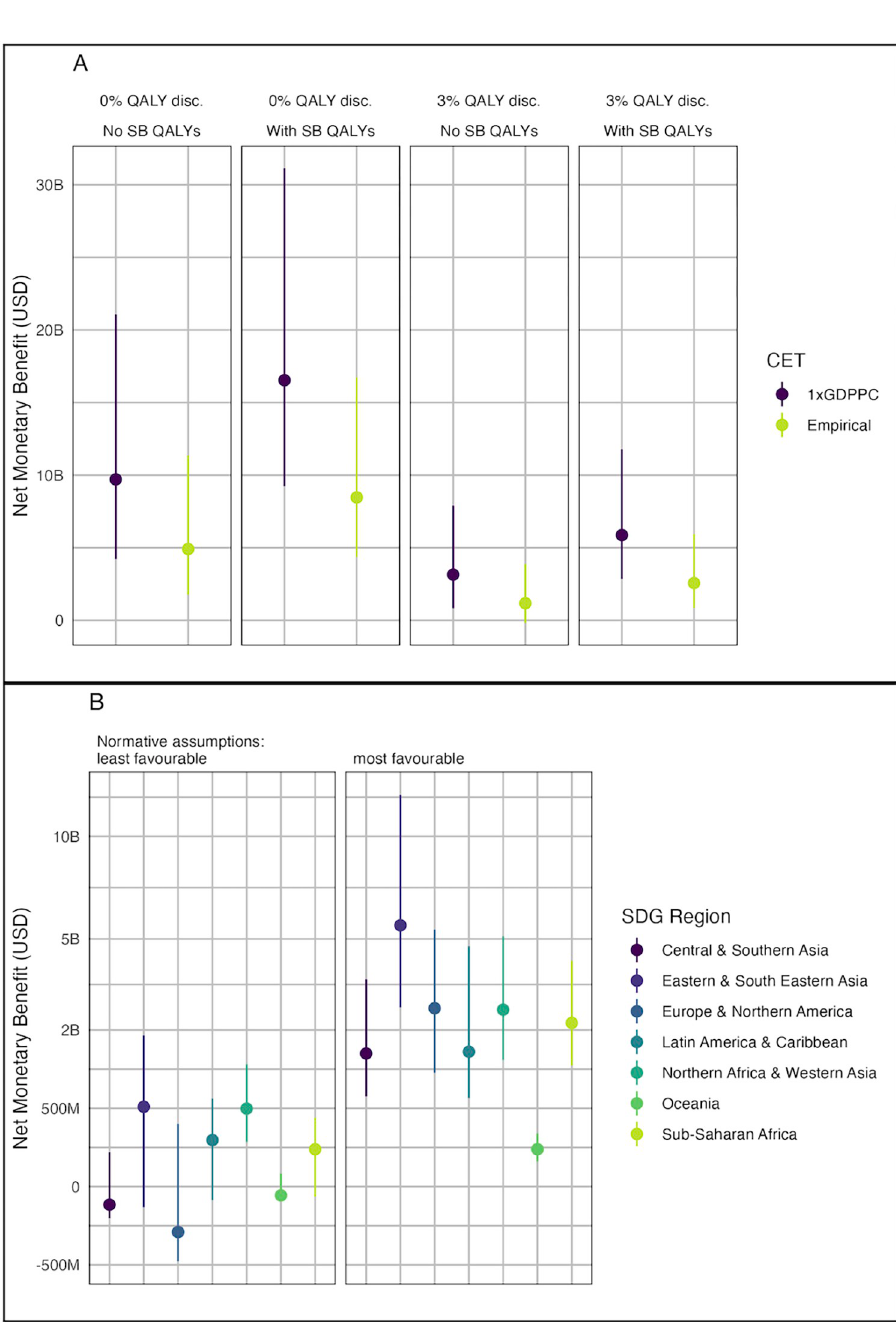
Fig 2. NMB of GBS maternal vaccination (A) globally under different normative assumptions (see Table 1) and (B) by region for the most and least favourable normative assumptions. Least favourable normative assumptions were the use of an empirical CET, 3% discounting of QALYs, and exclusion of stillbirth QALYs. Most favourable assumptions were the use of 1 × GDP per capita CETs, 0% discounting of QALYs, and inclusion of stillbirth QALYs. M, Millions; B, Billions; CET, cost-effectiveness threshold; GDP, Gross Domestic Product; GDPPC, GDP per capita; NMB, net monetary benefit; QALY, quality-adjusted life year; SB, stillbirth; SDG, Sustainable Development Goal.